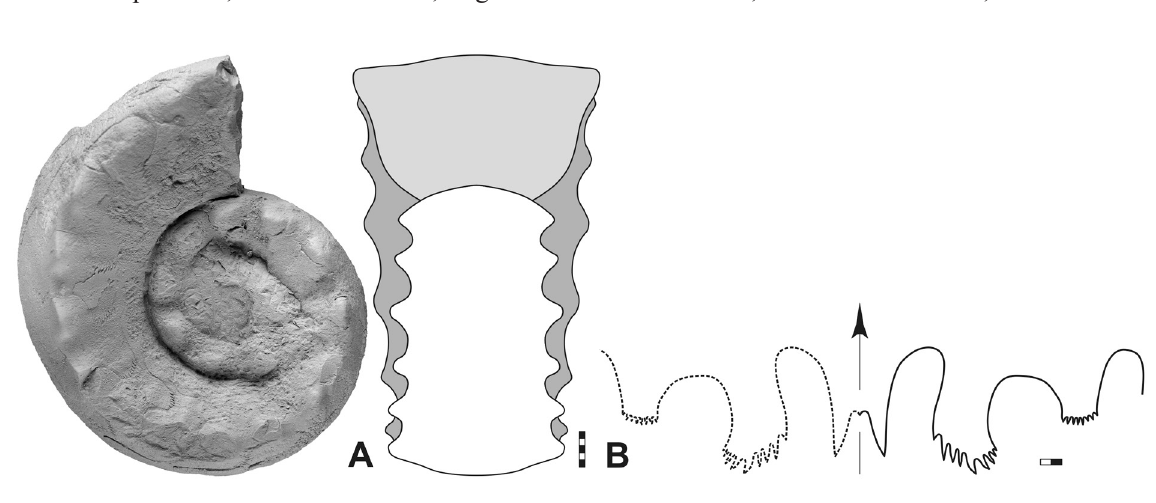
Fig. 31. Paratirolites coronatus Korn & Ghaderi, 2015. A . Lateral and dorsal view, specimen MB.C.29842, section E, float. B . Suture line, specimen MB.C.29842, at 48.7 mm dm, 17.8 mm wh. Abbreviations: see Material and methods. Scale bar units = 1